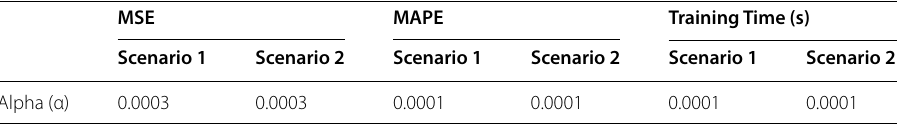
Table 10 Paired T -test result based on alpha